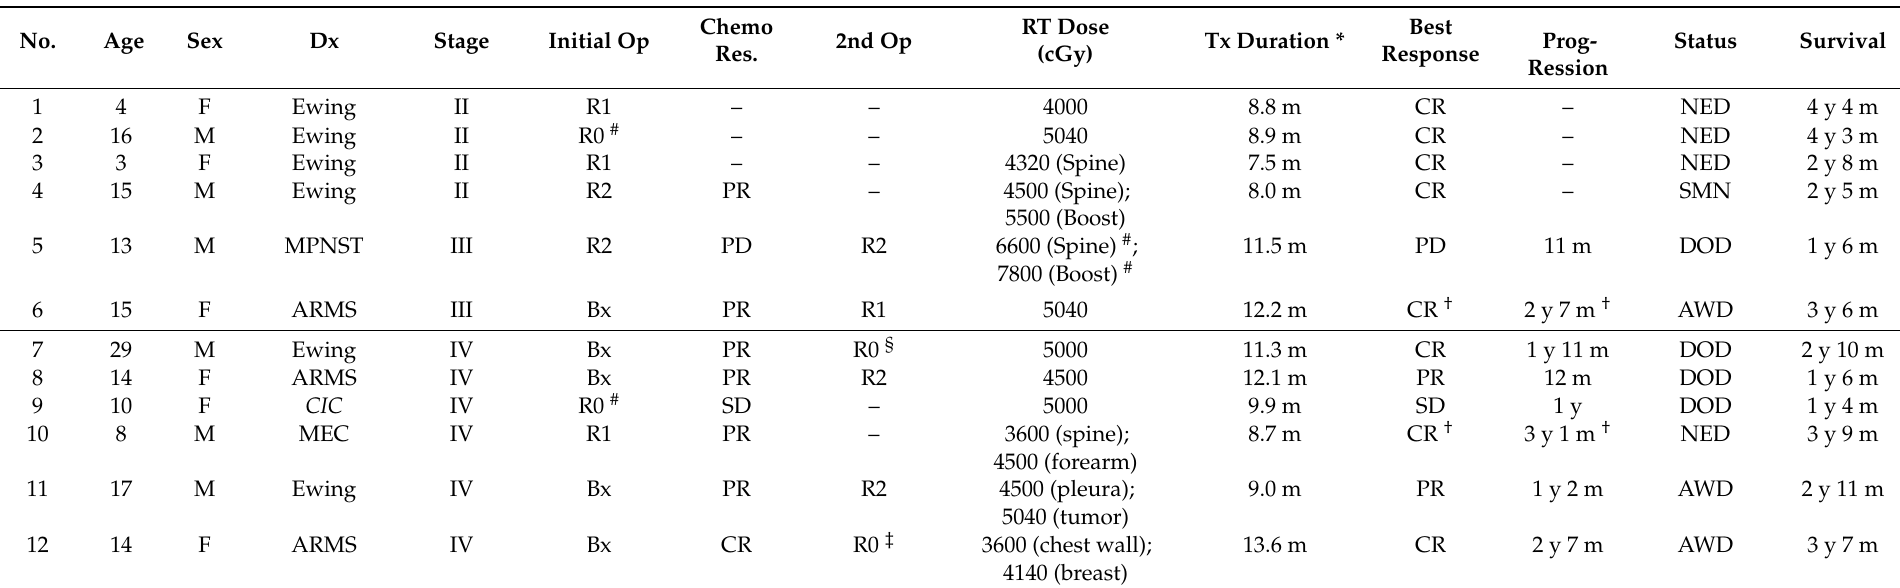
Table 3. Treatment and outcomes of Asian patients with